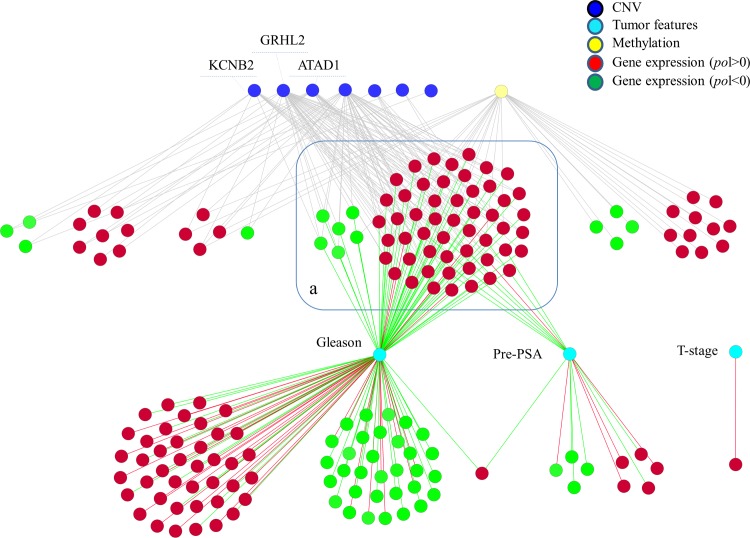
Integration of CNV, polarized genes, mRNA expression and tumour features.The figure summaries the relationship between gene CNV (blue), mRNA re-expression following hypo-methylating agents (yellow), polarized gene expression (red and green nodes are positively and negatively polarized genes, respectively) and tumour features (cyan). These relationships are the result of the statistical modeling described in the last section of the Results. Genes within the blue open rectangle (a) are under the influence of CNV and are linked to tumour features. Table 1 lists the genes within panel a and their functional classification according to Gene Ontology.